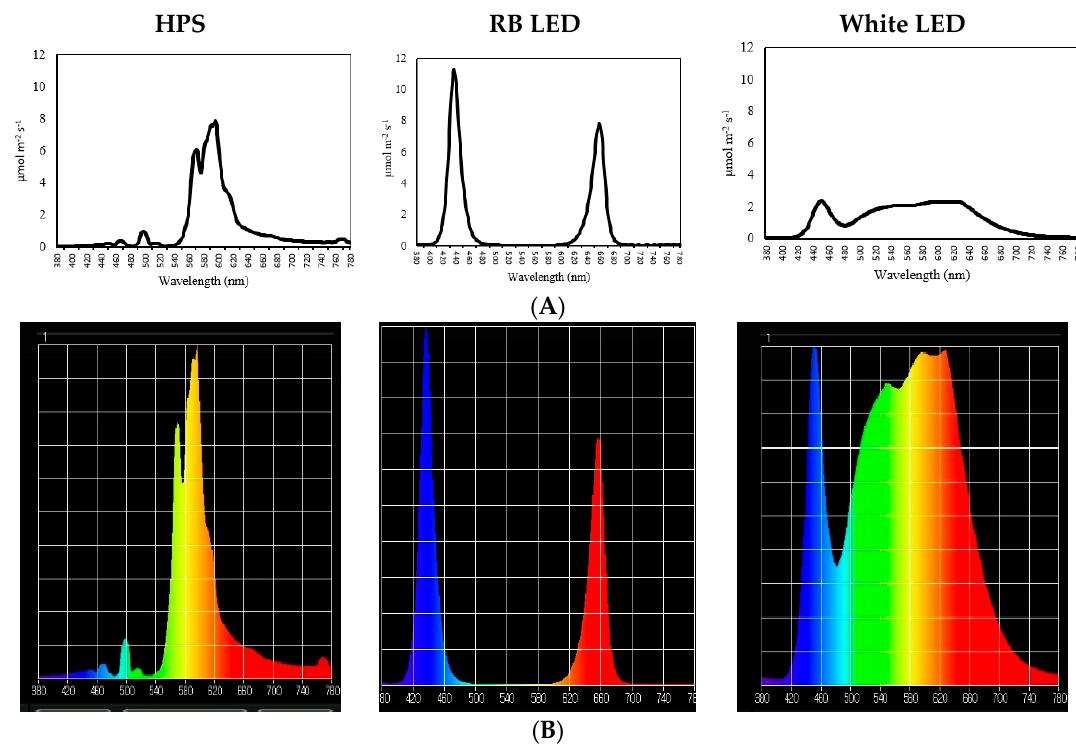
Figure 1. Spectra of the lighting units used as measured by UPRtek. ( A ) The radiant density of the light spectrum intensity. ( B ) The relative light intensity.